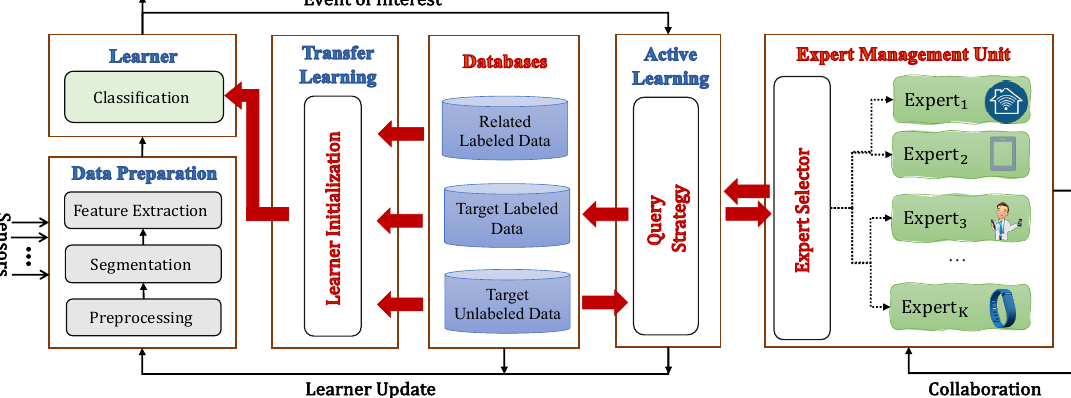
Figure 2. High-level representation of the proposed collaborative multi-expert active learning (Co-MEAL) architecture for mobile health